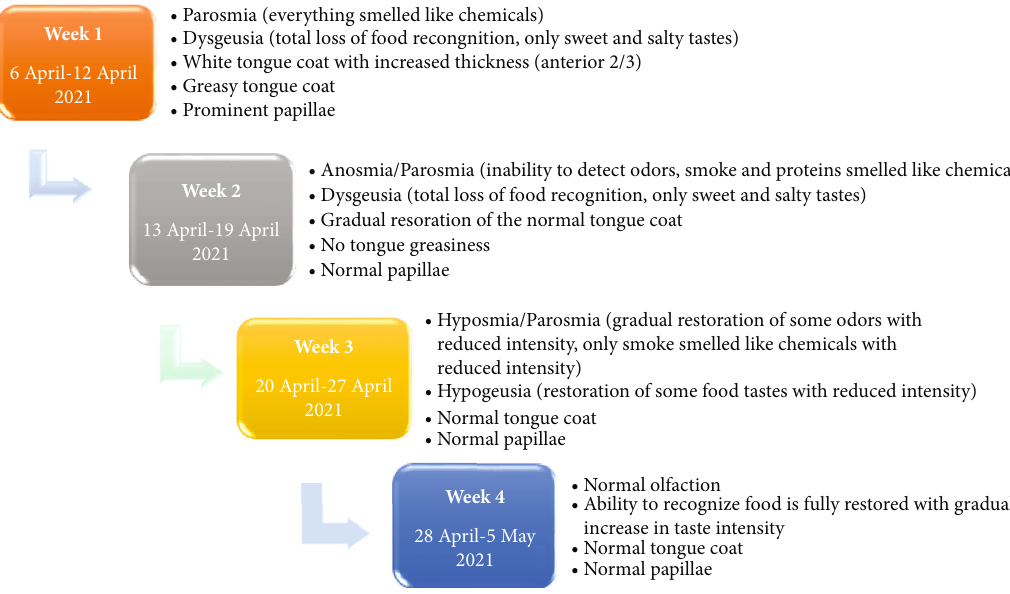
Figure 2: Timeline of the patient ’ s symptoms throughout four weeks of post-acute COVID-19